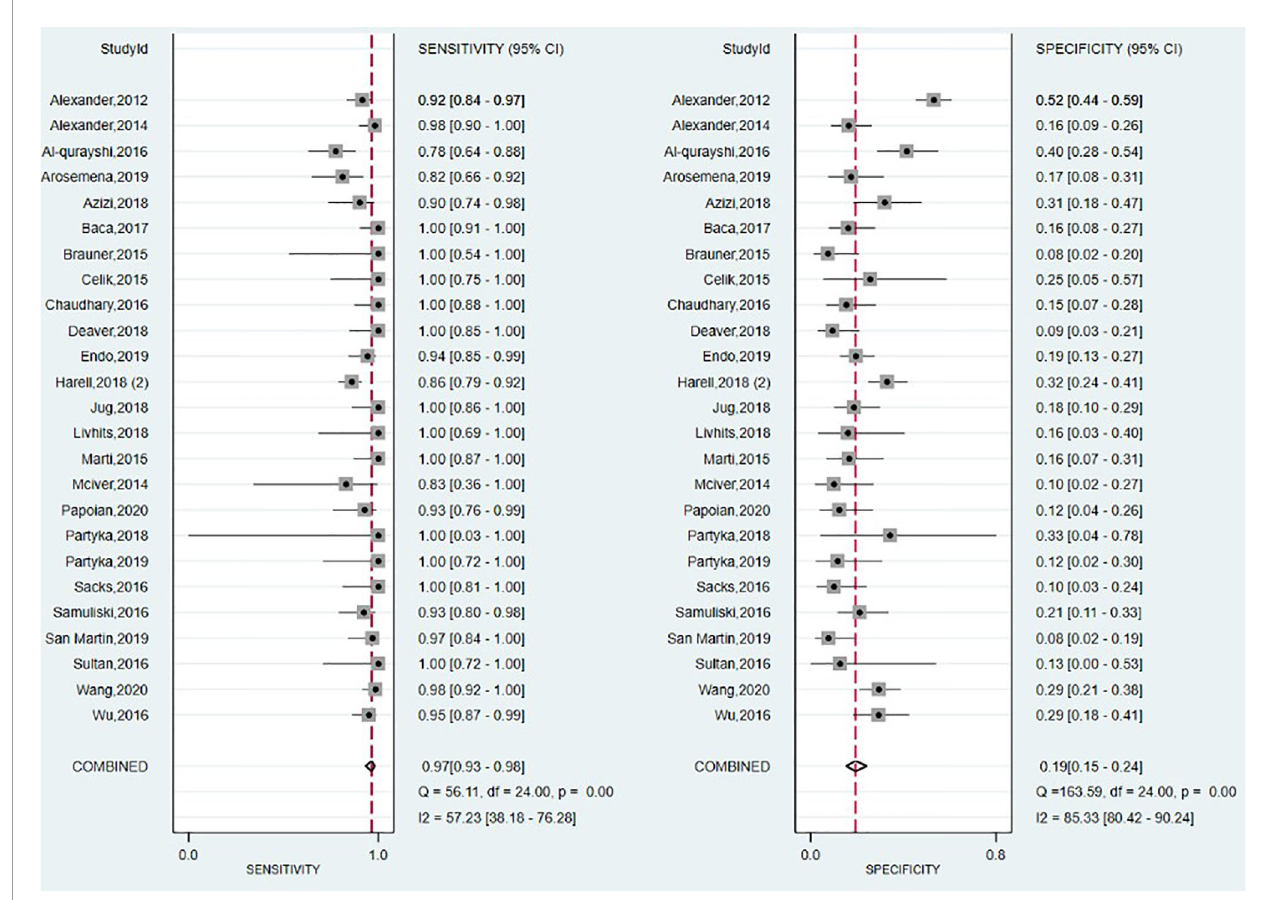
FIGURE 6 | Forest plot of sensitivity and speci fi city for A fi rma GEC